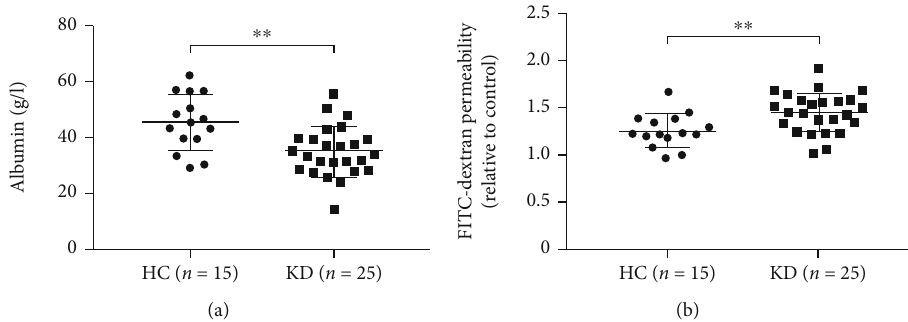
Figure 1: Vascular permeability is higher in the KD group. (a) Levels of serum albumin in healthy control (HC) children and acute KD (KD) patients. (b) Induction of permeability of HCAEC monolayers by medium containing 20% serum from HC children or KD patients. HCAEC monolayers treated by medium containing 10% fetal bovine serum (FBS) as control. ∗∗ P < 0 : 01 .